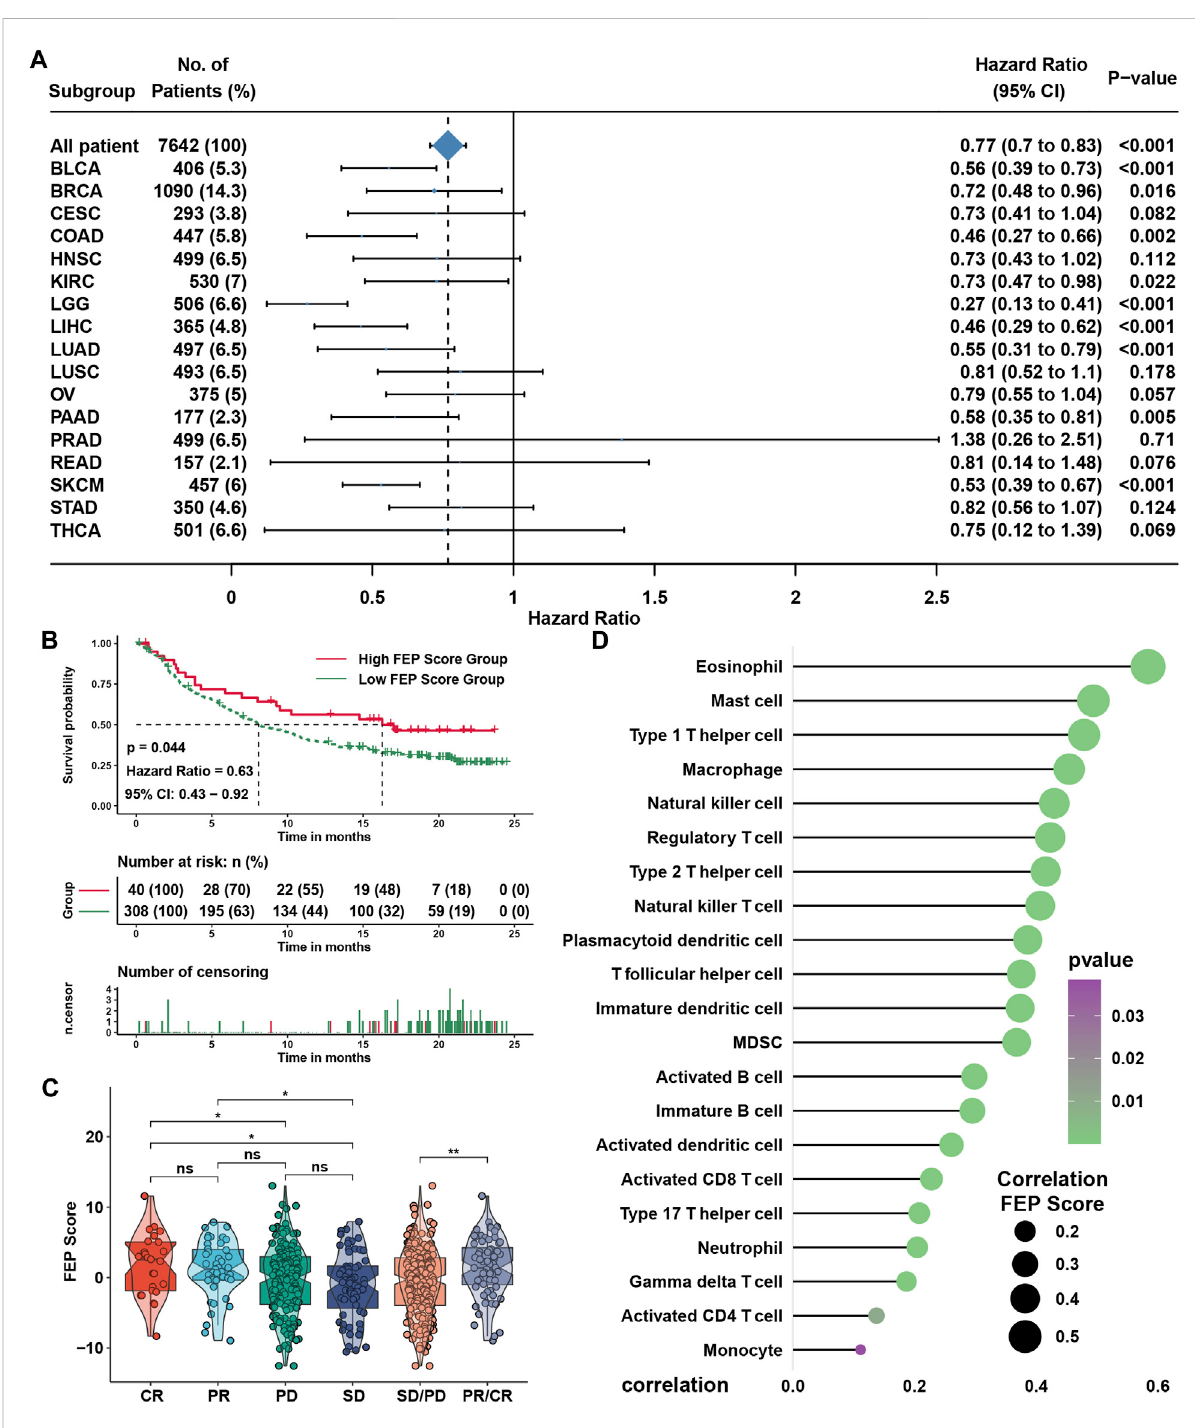
FIGURE 6 FEPregulatorypatternsinpan-cancerandtheroleinimmunotherapy. (A) SubgroupanalysesevaluatingprognosticvalueofFEPscoreinvarious types of cancer from TCGA datasets. HR > 1.0 indicated high FEP score as a protective prognostic factor. (B) Survival analysis for FEP score in IMvigor210 cohort. (C) Distribution of FEP score in groups with distinct clinical responses to anti-PD-L1 treatment. (D) Correlation analysis between FEP score and in fi ltration levels of immune cell in IMvigor210 cohort. The asterisks represented the p values (* p < 0.05; ** p <